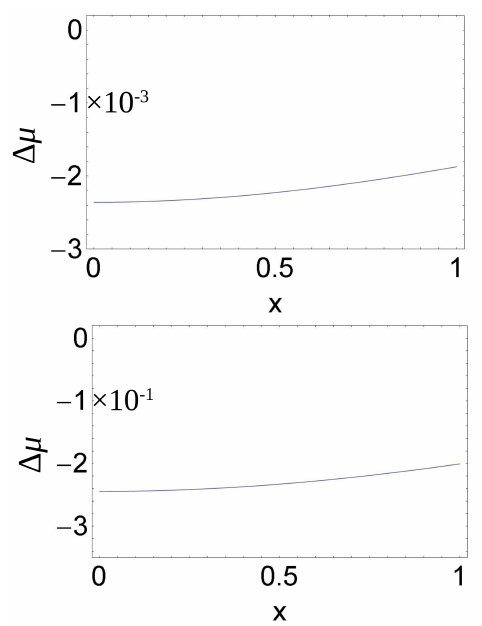
Figure 5. Phase difference ∆ µ = µ III − µ I at t = T between the Case III and Case I cavities obtained from numerical computations. (Top) The Case III cavity is in the adiabatic regime (corresponding to the parameters given in Figure 3). Applying the analytical expression (32), the phase difference is constant and computed to be µ ad − µ I = − 2.2 × 10 − 3 . (Bottom) The Case III cavity is in a nonadiabatic regime (the parameters are those given in Figure 4). Note the phase difference is two orders of magnitude higher than in the adiabatic case. Atomic units are used (the length unit is the Bohr